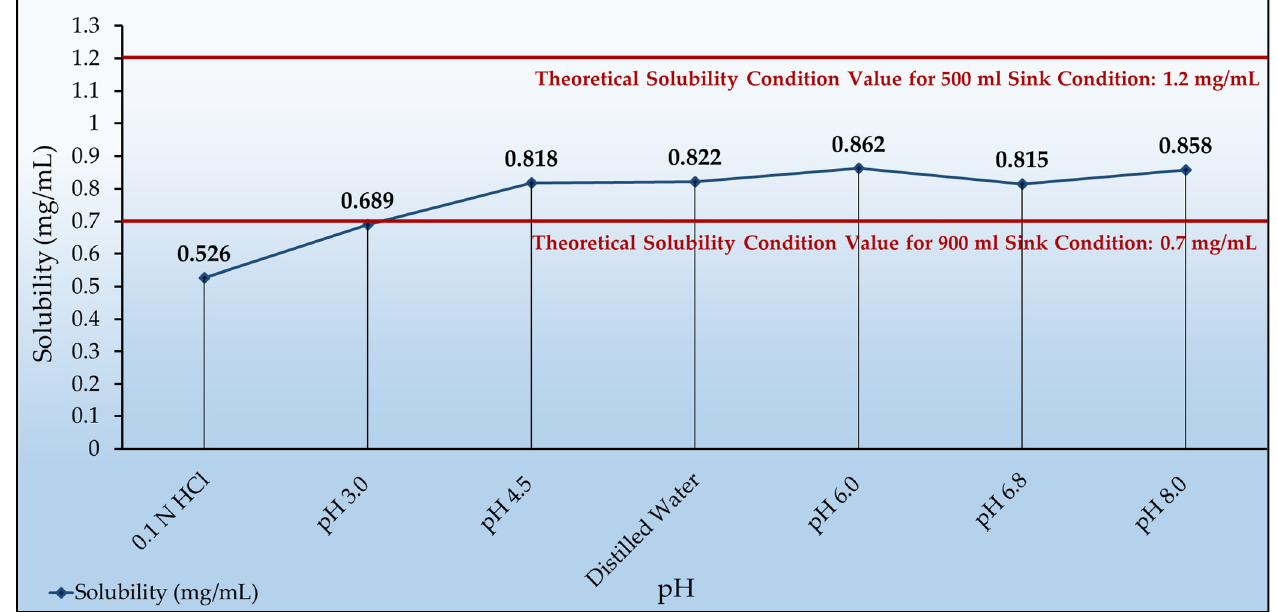
Figure 2. Graphical presentation of solubility versus pH of favipiravir in different media and in different dissolution volumes.